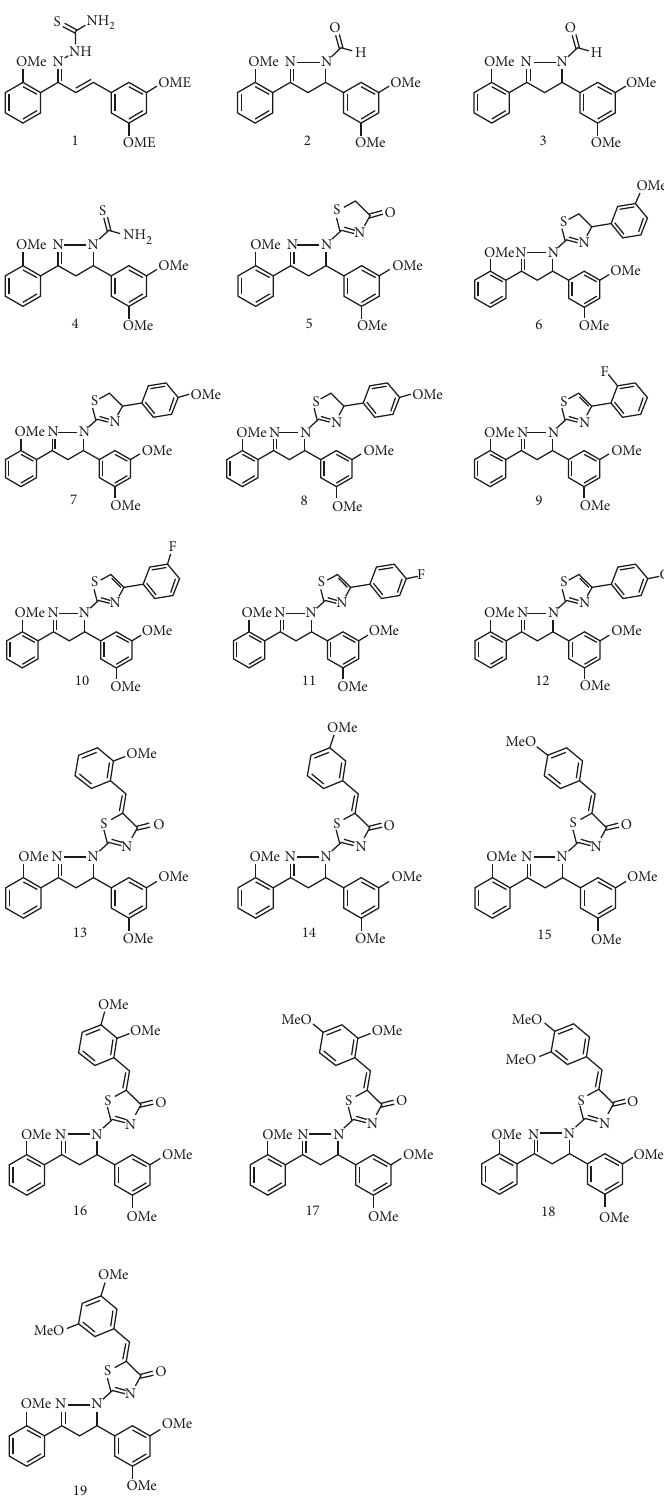
Figure 2: The chemical structures of 3,5-diphenyl-2-pyrazoline